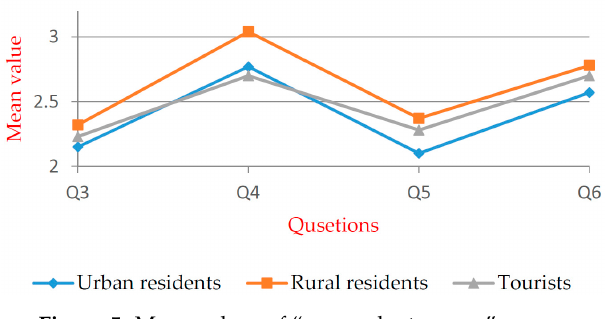
Figure 5. Mean values of “respondent source” group.